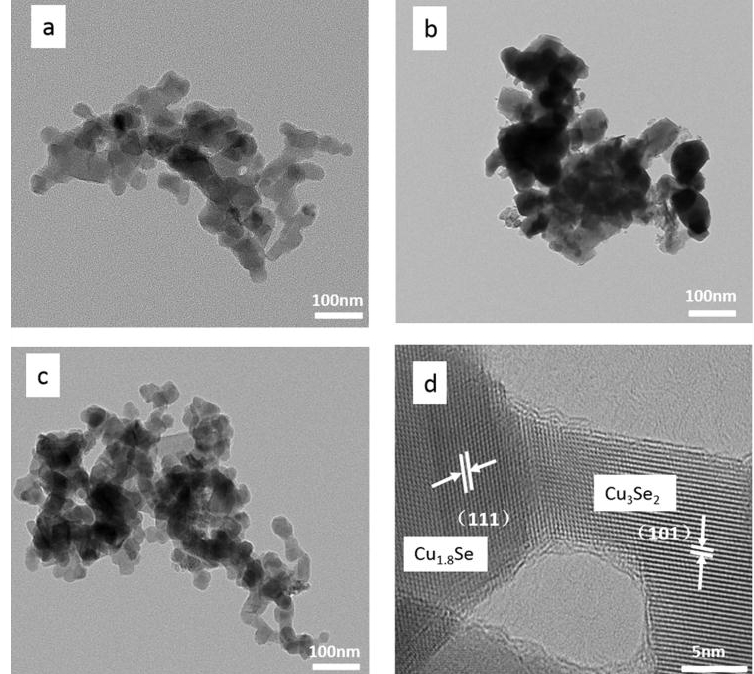
Figure 2. TEM (transmission electron microscopy) images of ( a ) Cu 1.8 Se; ( b ) Cu 3 Se 2 ; ( c ) Cu 1.8 Se/Cu 3 Se 2 composite; ( d ) HRTEM (high resolution transmission electron microscopy) of Cu 1.8 Se/Cu 3 Se 2 composite.